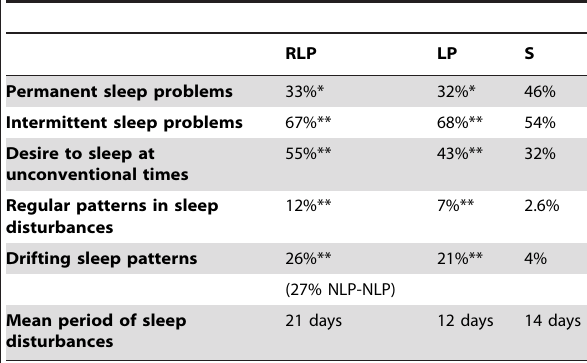
Table 5. Sleep disturbances in respondents with one or more sleep